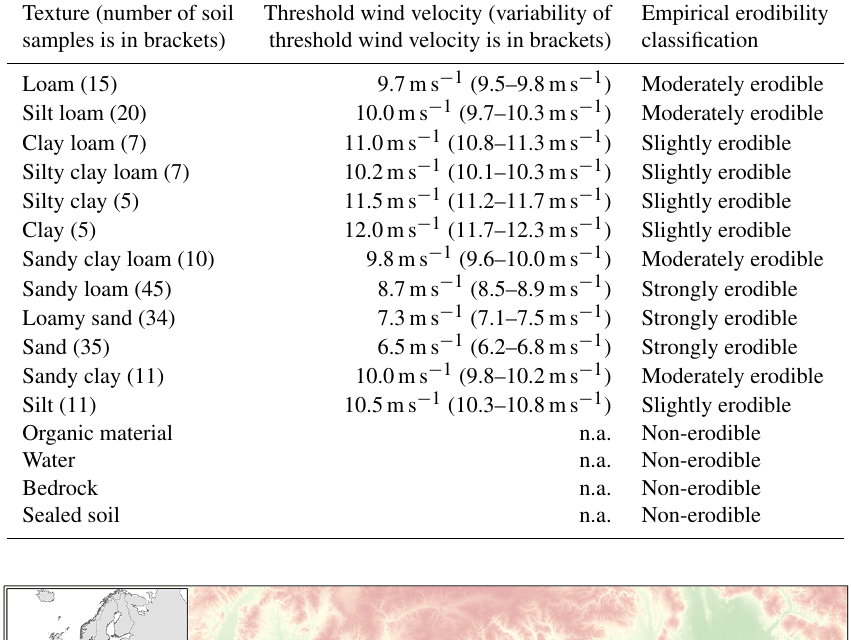
Table 1. Aggregated threshold wind velocity values by texture class.